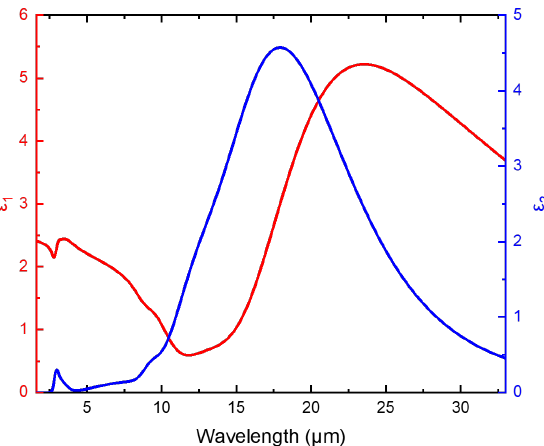
Figure 1. Depiction of the square unit cell used in COMSOL modeling. The metasurface is composed of three layers: an IP-Dip polymer fin, a 50 nm Au dipole layer atop the fin, and a 50 nm layer surrounding the base of the fin. Fused silica is used as a substrate.